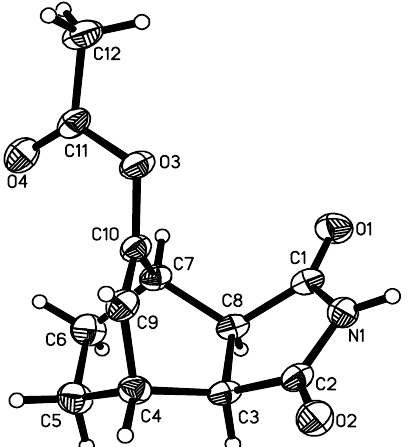
fragment are: C1-O1 1.206(2), C1-N1 1.383(3), C2-O2 1.217(2), C2-N1 1.365(3), C1-C8